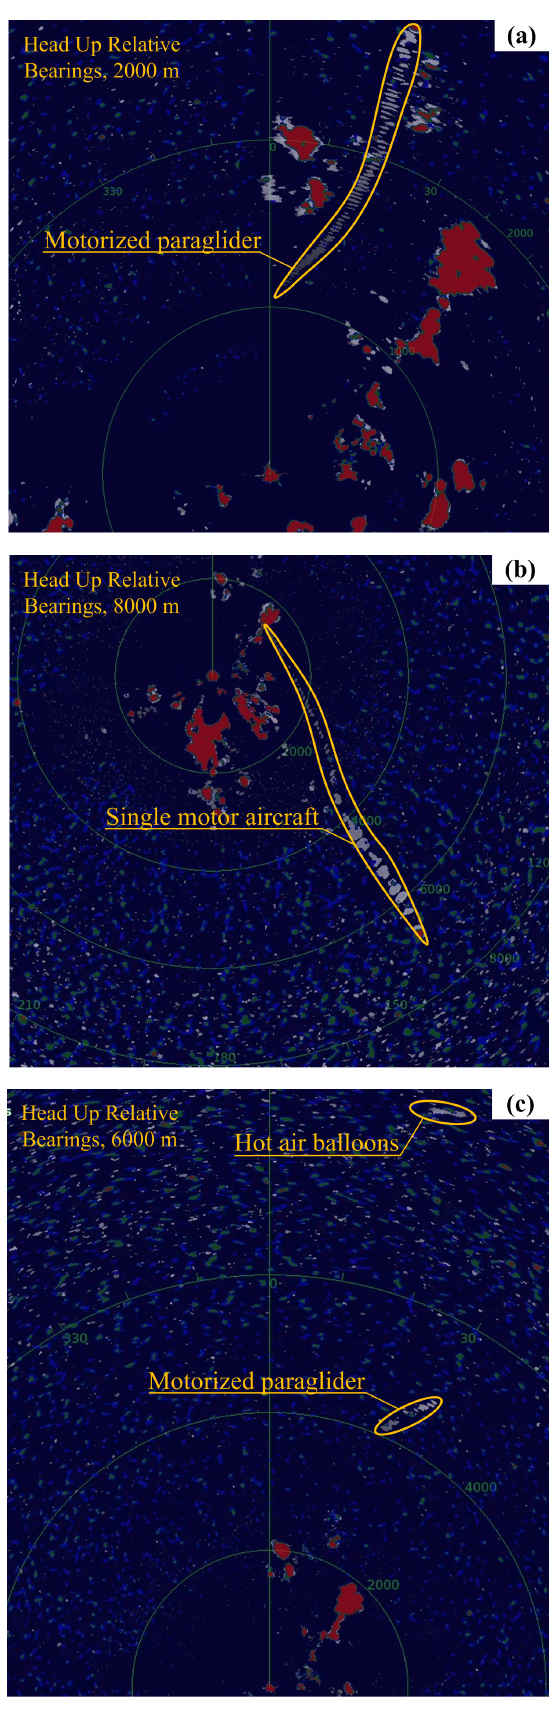
Figure 10. Detection of the ( a ) motorized paraglider, ( b ) single motor aircraft, and ( c ) motorized paraglider and hot air balloons by Halo3